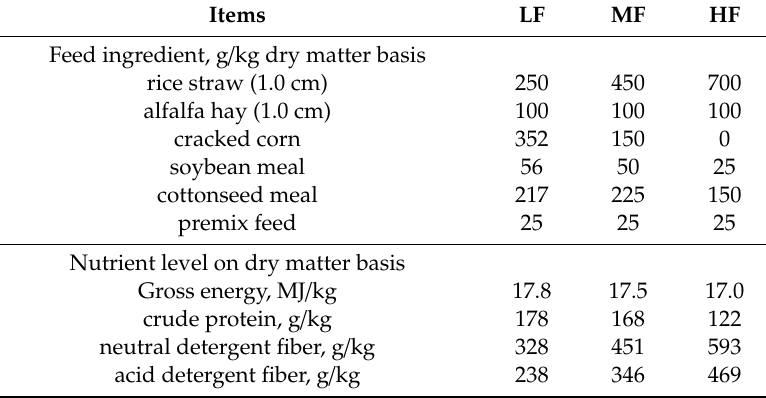
Table 1. Feed ingredient and nutrient level of low- (LF, forage / concentrate ratios (F / C) = 35:65), medium- (MF, F / C = 55:45) and high-fiber (HF, F / C = 80:20) donkey rations with di ff erent forage / concentrate ratios (F / C). Items LF MF HF Feed ingredient, g / kg dry matter basis rice straw (1.0 cm) 250 450 alfalfa hay (1.0 cm)